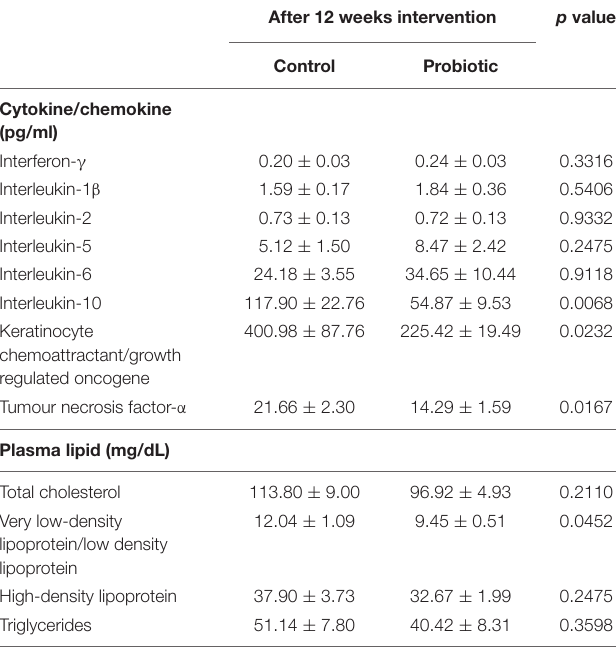
TABLE 2 | Plasma cytokine/chemokine and lipid